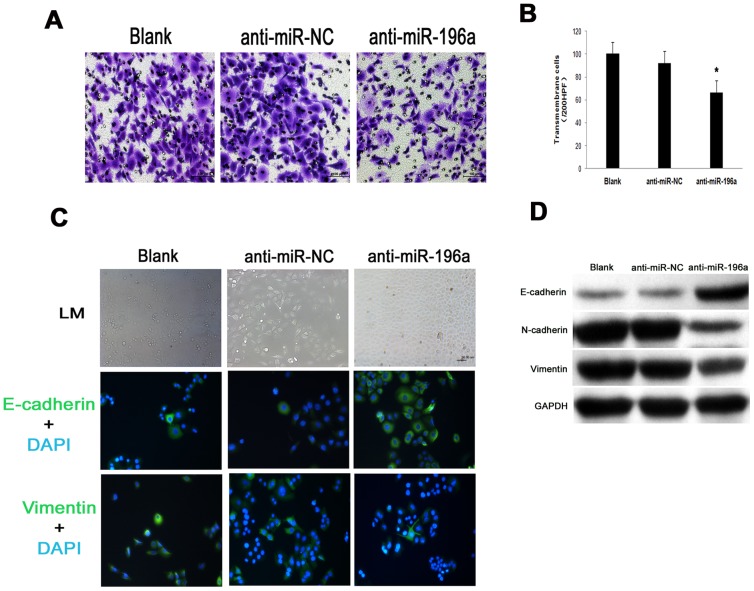
Downregulation of miR-196a suppressed PANC-1 cell migration.(A) Representative transwell assay indicated that the migration ability of PANC-1 cells was markedly reduced by down-regulation of miR-196a. (B) Comparison of transmembrane cells among anti-miR-196a, anti-miR-NC and Blank (*, P<0.05). (C) Morphological changes and immunofluorescence staining of MET markers among anti-miR-196a, anti-miR-NC and blank. (D) Representative western blot analysis revealed that mesenchymal-epithelial transition contributed to suppression of PANC-1 cell migration after silencing miR-196a. After silencing miR-196a, E-cadherin expression increased, as well as expression of N-cadherin and Vimentin decreased.